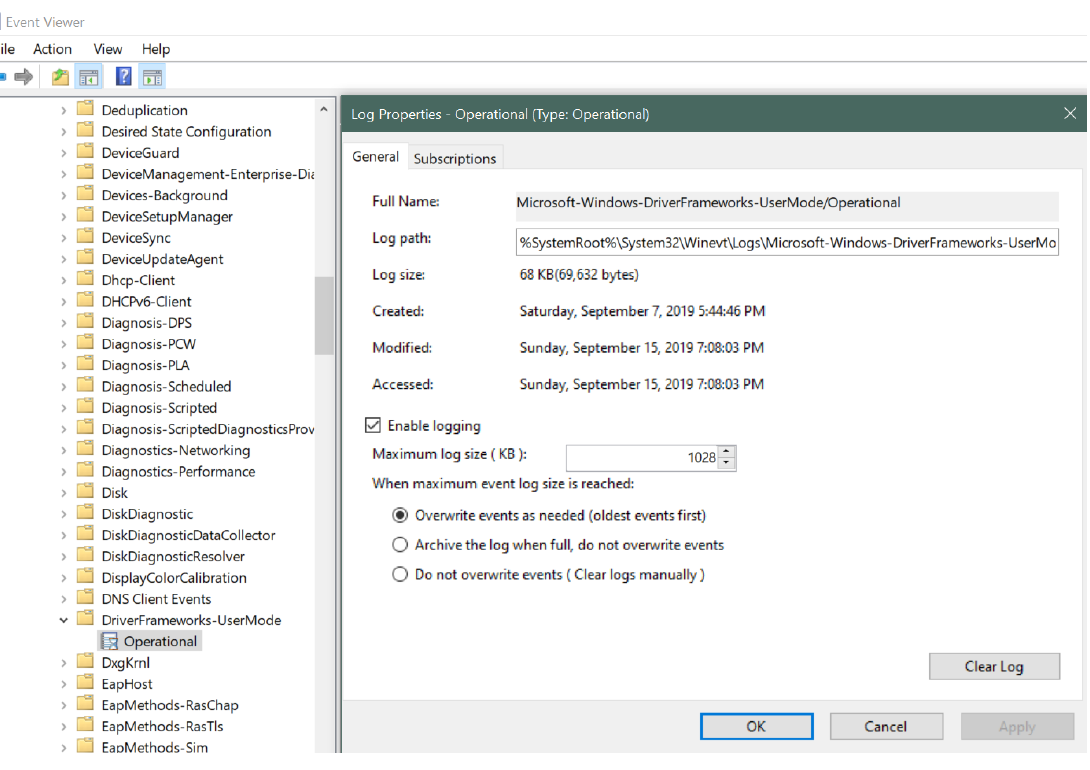
Figure 2. Enable USB logging in Event